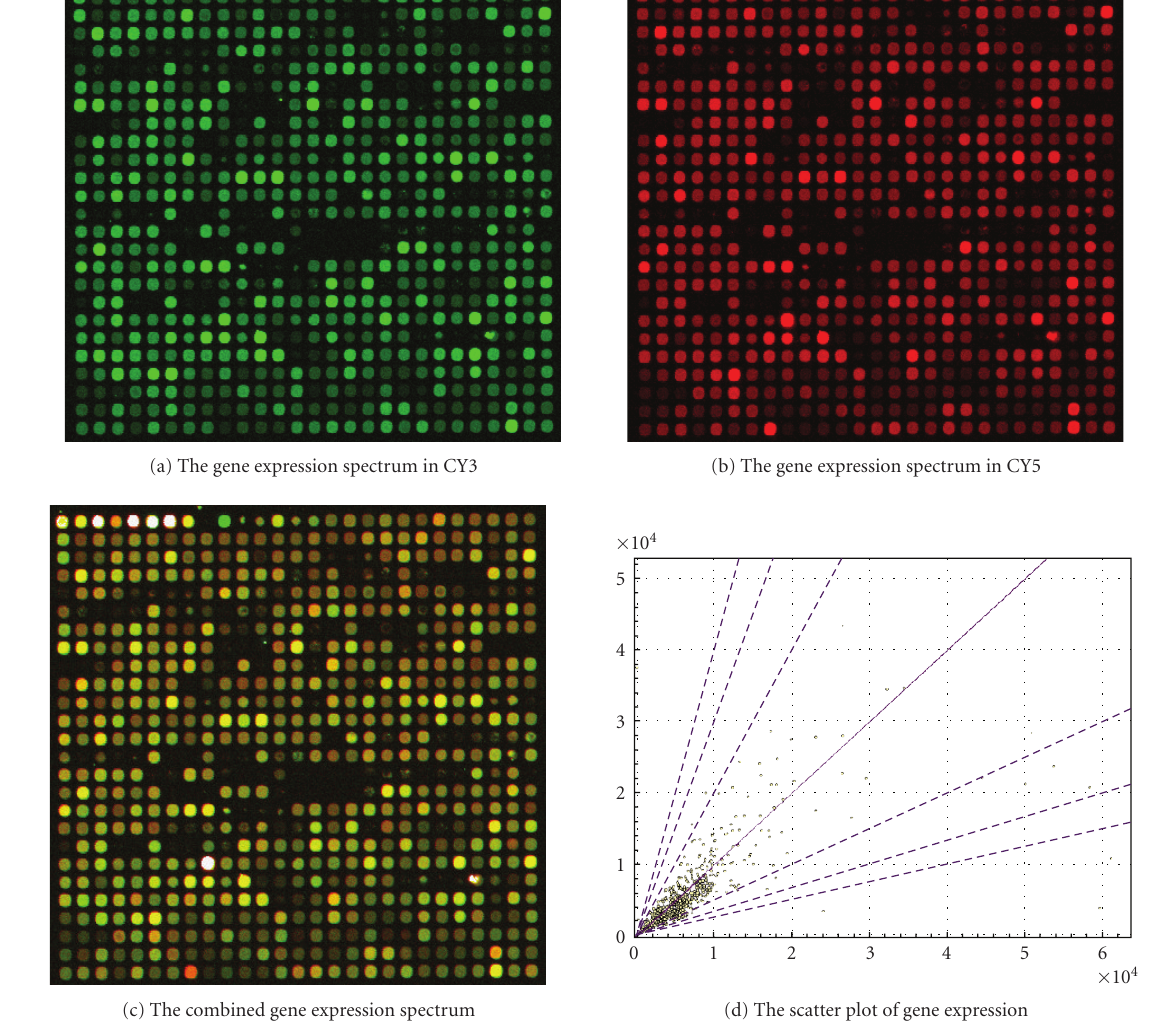
Figure 8: The gene expression spectra of a high-yield cotton compared to a common cotton